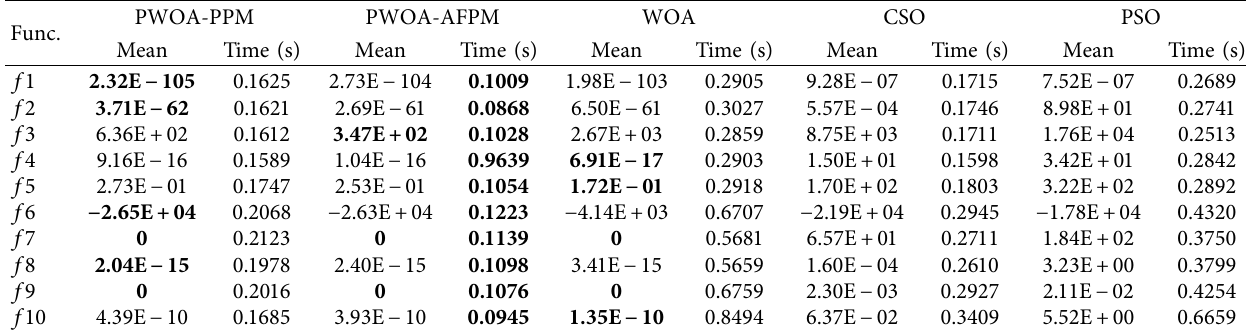
Table 2: Comparison between the proposed algorithms and the state-of-the-art algorithms (64D). Func.